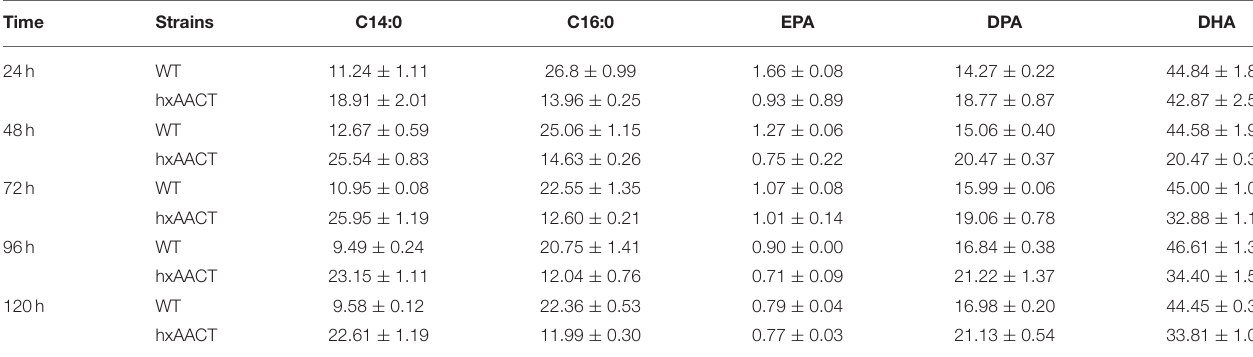
TABLE 1 | The percentage of fatty acids (w/w%) in WT and hxAACT at 24, 48, 72, 96, 120h in 500-mL shake flasks.